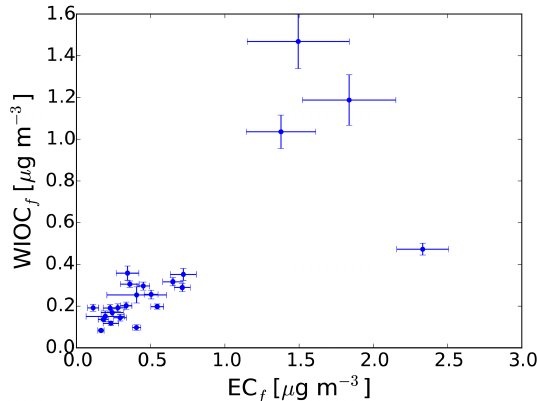
Figure 9. A scatter plot of EC concentrations from fossil-dominated sources (EC f ) versus concentrations of water-insoluble fossil car- bon (WIOC f )